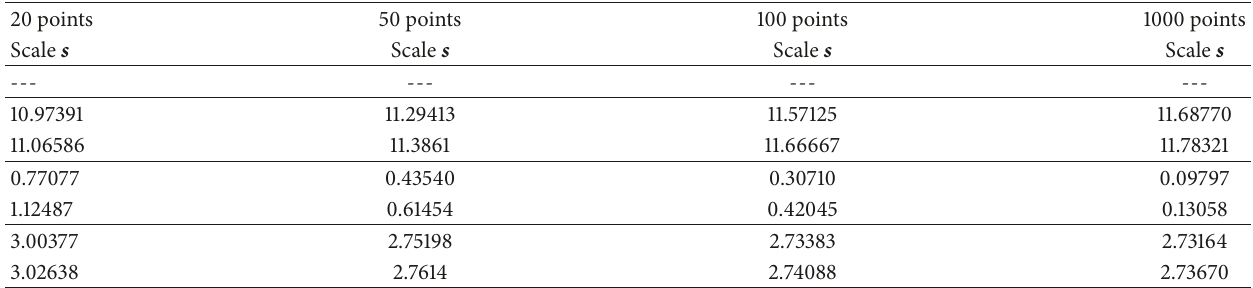
Table 43: Contaminated 𝜒 2 distributions with 30% noise level.